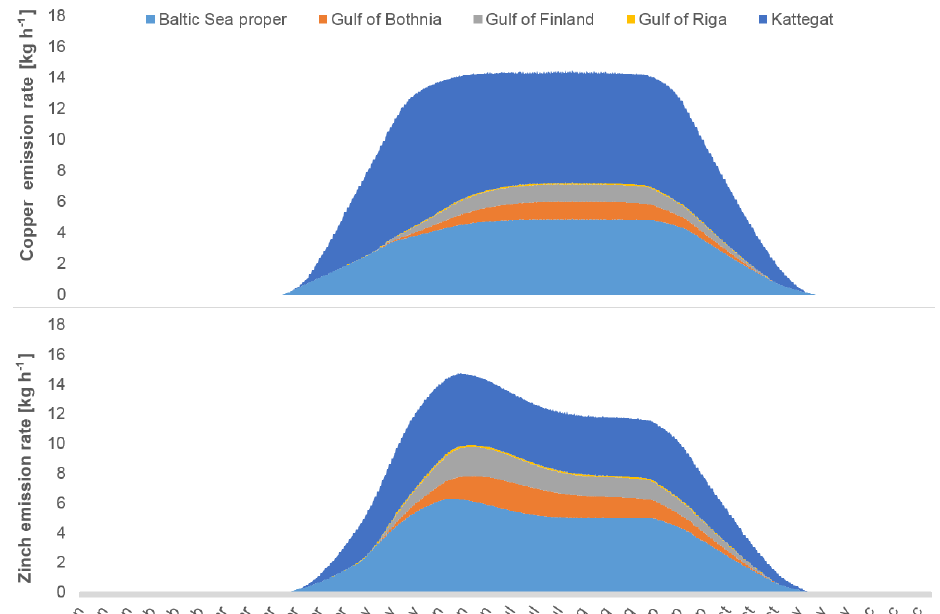
Figure 10. Modeled antifouling paint contaminant leaching rates for different parts of the Baltic